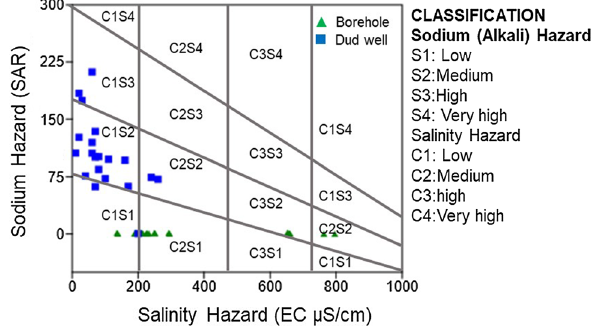
Fig. 12 USSL classification of groundwater samples from shallow and deep